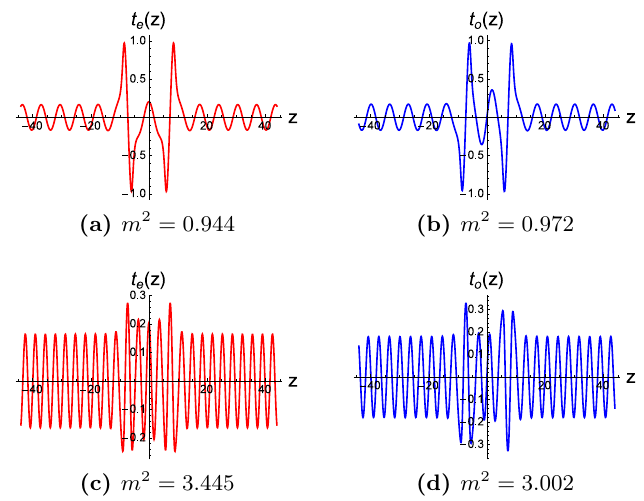
Figure 8. Plots of the even and odd parity resonance modes quasi-localized on the sub-branes for the double brane model (3.8). The parameters are set to k = 1, b = 7, and d = 1 : 6.